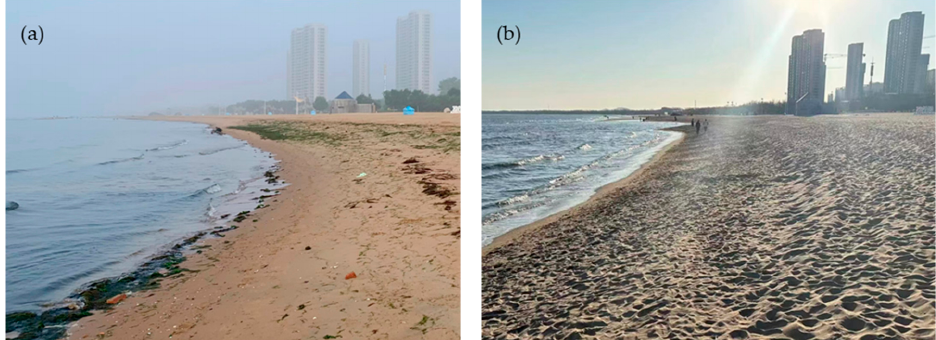
Figure 1. A view of Jinmeng Beach on ( a ) 7 July 2021; ( b ) 24 March 2023.